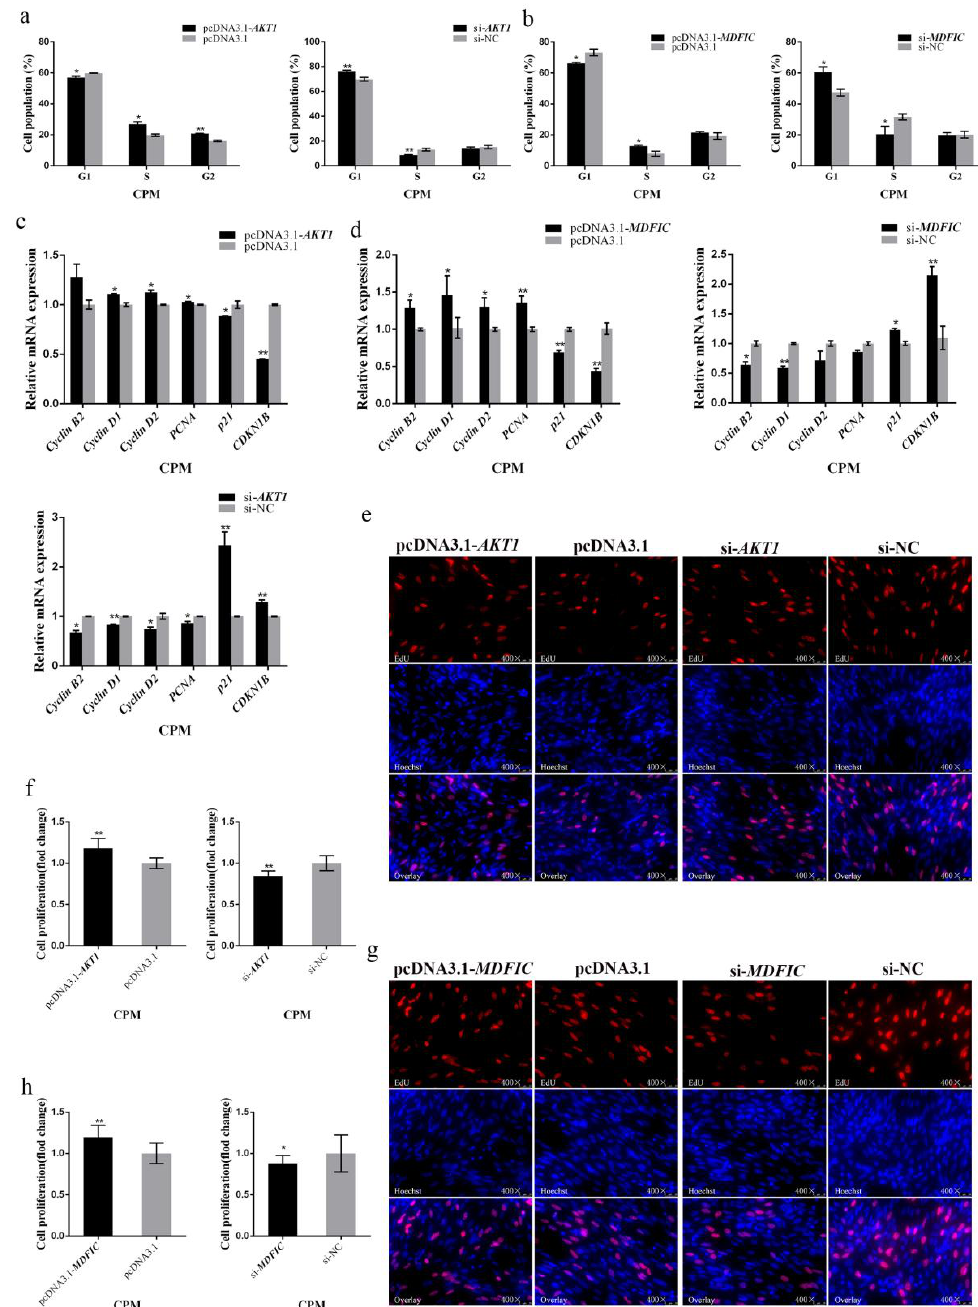
Figure 5. AKT1 and MDFIC promote myoblast proliferation . ( a ) Cell cycle analysis of CPMs after overexpression or inhibition of AKT1 . ( b ) Cell cycle analysis of CPMs after overexpression or inhibition of MDFIC . ( c ) Relative mRNA expression of the cell cycle-related genes after overexpression or inhibition of AKT1 in CPMs. ( d ) Relative mRNA expression of the cell cycle-related genes after overexpression or inhibition of MDFIC in CPMs. ( e ) EdU staining of CPMs after overexpression or inhibition of AKT1 . ( f ) The fold change of proliferation rates of CPMs with pcDNA3.1- AKT1 or si- AKT1 . ( g ) EdU staining of CPMs after overexpression or inhibition of MDFIC . ( h ) The fold change of proliferation rates of CPMs with pcDNA3.1- MDFIC or si- MDFIC . Results of all groups are shown as mean ± S.E.M. of three independent assessment methods. Statistical significance of the mean di ff erence was assessed using unpaired two-sample t -tests. * p < 0.05; ** p < 0.01. NC, negative